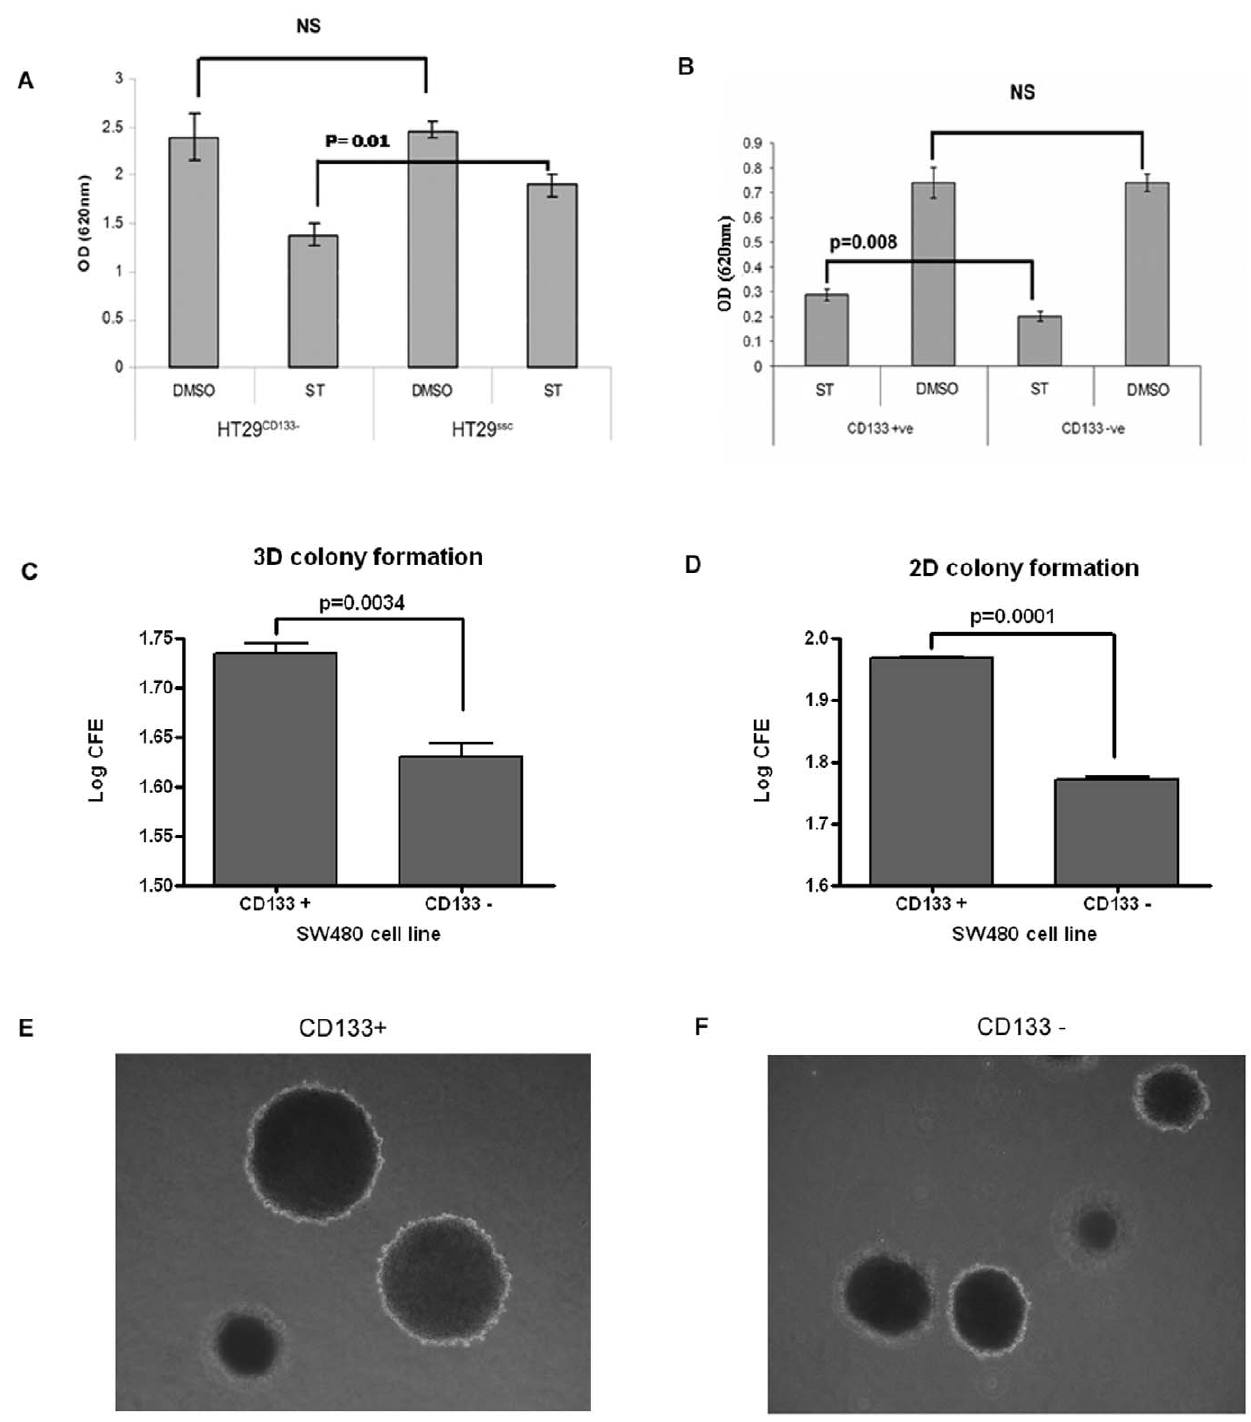
Figure 5. Association of CD133 expression with features of stemness. CD133 gave resistance to staurosporine induced apoptosis. Figure 5a shows that after exposure to staurosporine there were fewer viable cells after transfection with CD133 specific siRNA (HT29 CD133 2 ) than with scrambled control (HT29 ssc ) (p=0.01). There were no differences between the cells after exposure to DMSO. Figure 5b shows that the CD133 + population of SW480 showed cells showed significantly greater resistance than the CD133 2 population (p=0.008). Figure 5c and 5d show CD133 + cells were significantly more clonogenic than CD133 2 cells (p , 0.0001 and p , 0.003) in 2D and 3D culture respectively. Figures 5e (colonies formed by CD133 + cells) and 5F (colonies formed by CD133 2 cells) show that both CD133 + and CD133 2 populations of SW480 were able to form colonies from single cells (typical colonies are shown).